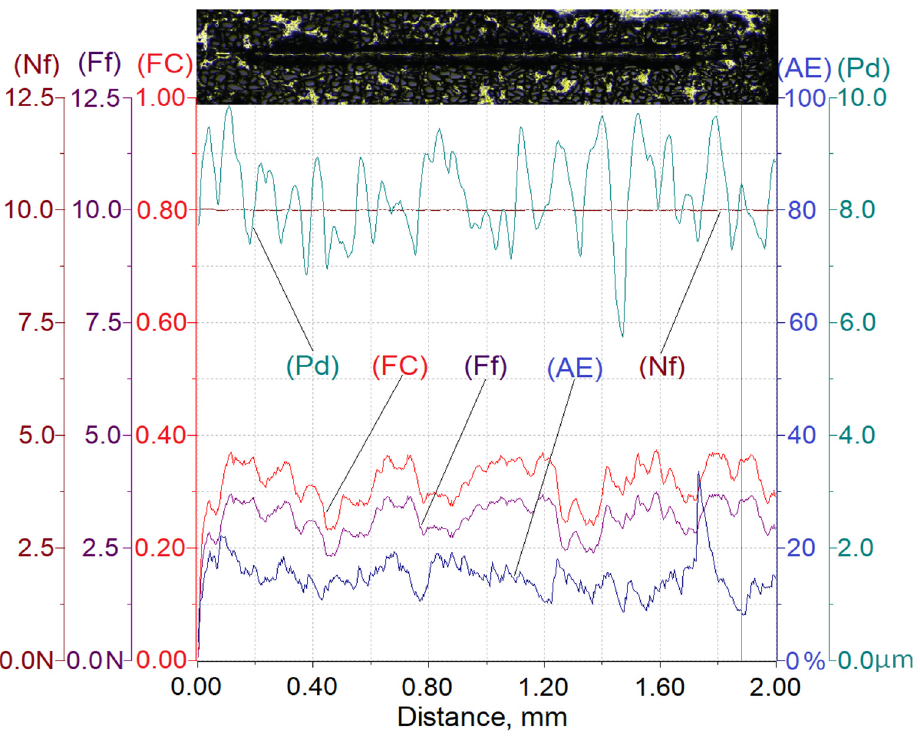
Figure 10. Results of AlSi12 / SiC p composite layer scratch testing for the normal load force Nf = 10 N; Nf—normal force, Pd—penetration depth, Ff—frictional force, FC—friction coefficient, AE—acoustic emission.